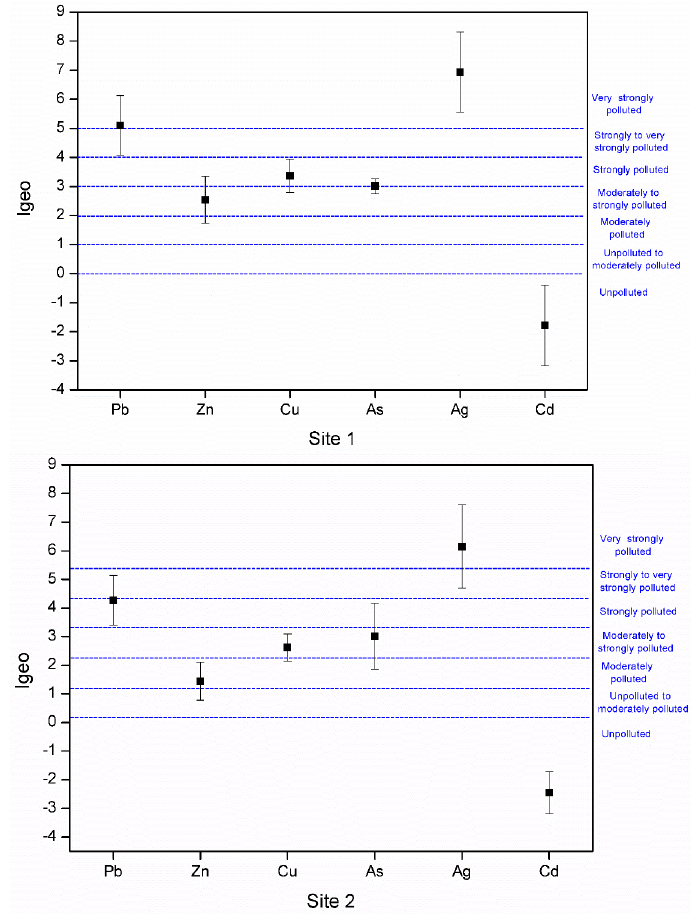
Figure 3. Geo-accumulation index ( I geo ) for Pb, Zn, Cu, As, Ag, and Cd at the sampling sites .